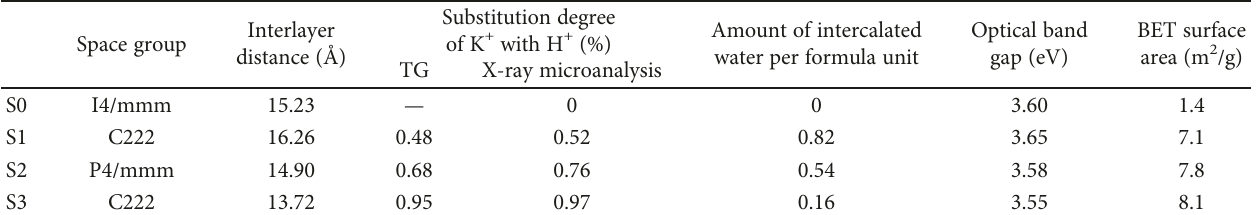
Figure 2: Thermogravimetric curves of protonated Rb La Ti O samples S0, S1, S2, and S3: interlayer distance, protonation degree measured by TG and 2 2 3 10